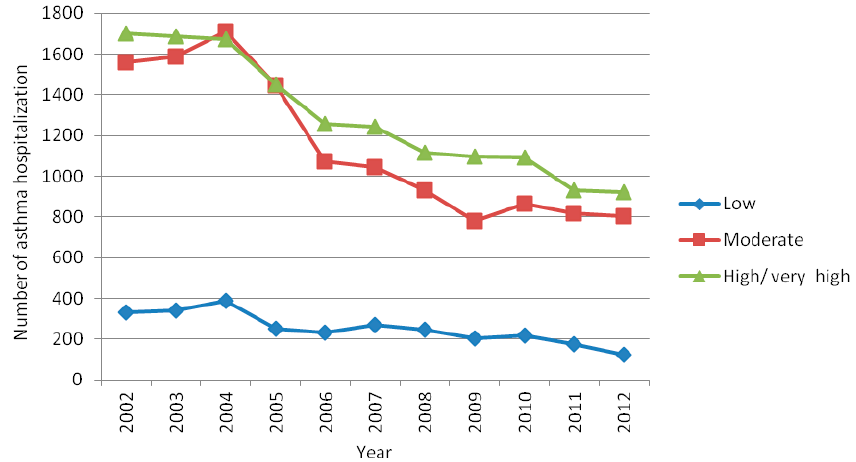
Figure 4. Frequency of asthma-related hospitalizations in children and adolescents aged 0 ‒ 14 years